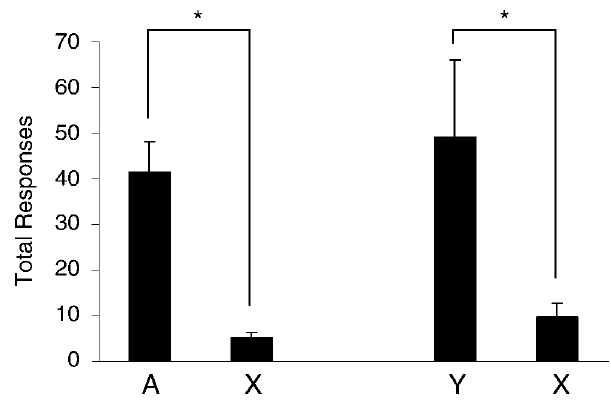
Figure 3. Acquisition of a new response mediated by devaluation- insensitiverepresentationsofgeneralaffect .Thisgraphshowstheaverage total number of responses for cue B versus the control cue over three, 30- minute sessions on an VR2 schedule. The right side of the graph shows responding in rats for whom the O2 pellet was devalued (B-D). The left side of the graph shows responding in rats for whom the O2 pellet was not devalued (B-ND). Rats responded significantly more for B than for the control cue, and there was no effect of devaluation (*, p<0.05; **, p<0.10).